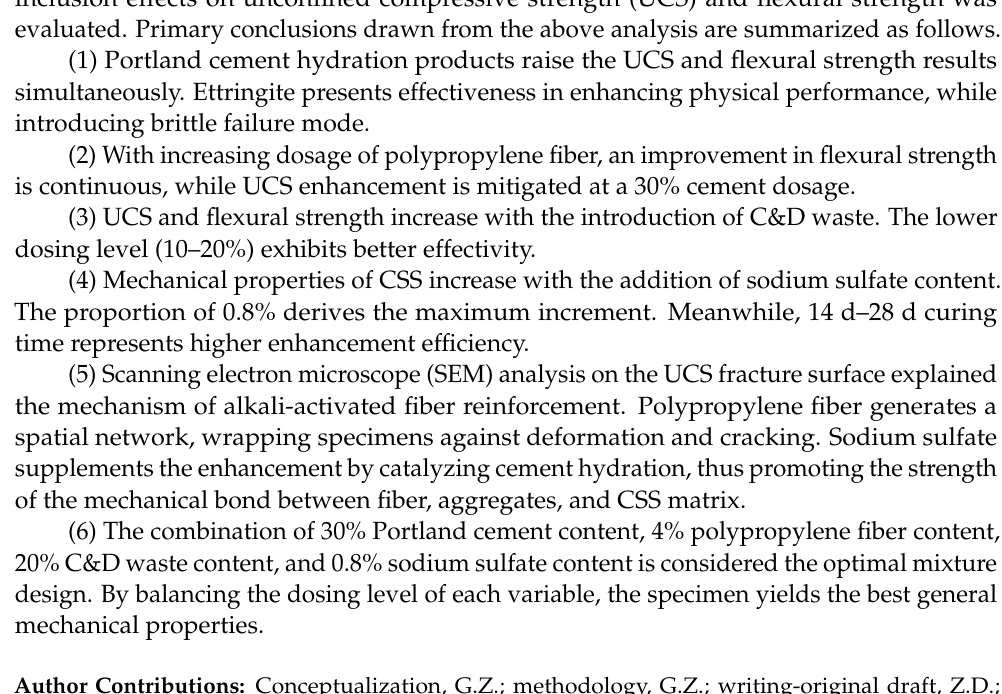
Figure 10. Microstructure of polypropylene fiber: ( a ) untreated fiber; ( b ) alkali-treated fiber.